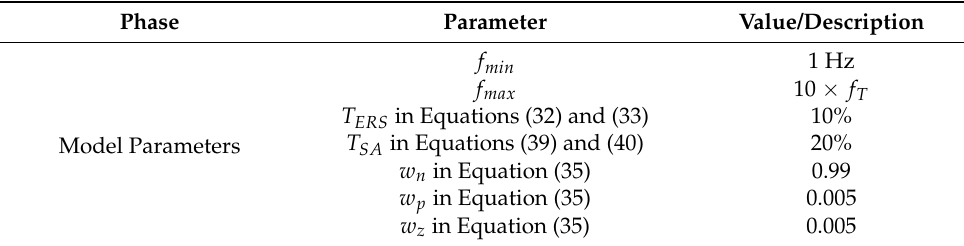
Table 2. Model parameter